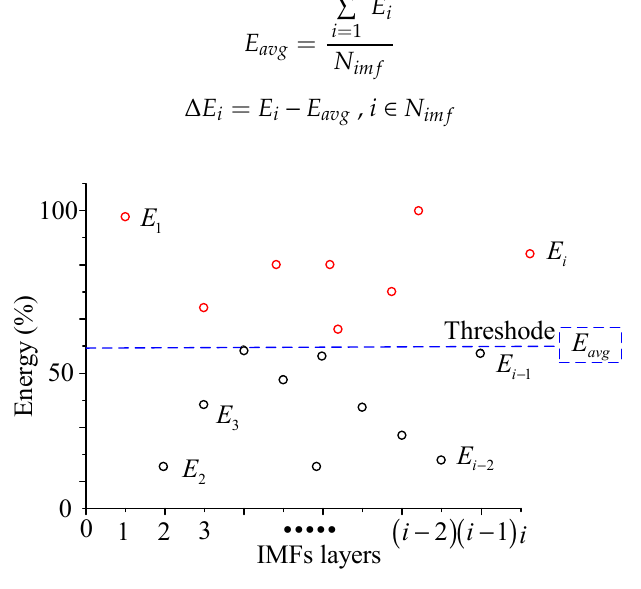
Figure 3. Energy distribution model.